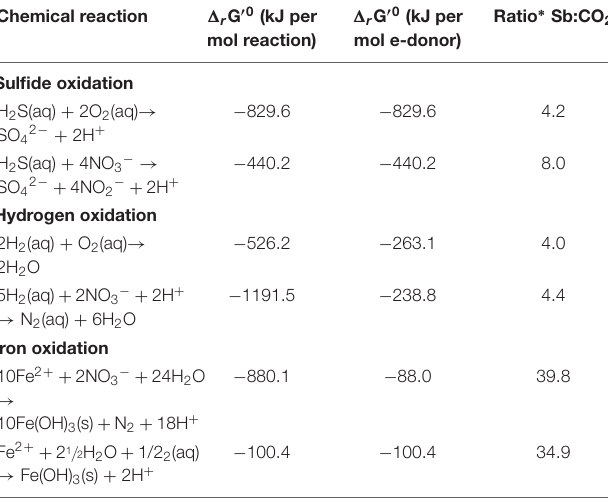
TABLE 3 | Chemical reactions and standard Gibbs energies per mol of electron donor for different catabolic reactions. Chemical